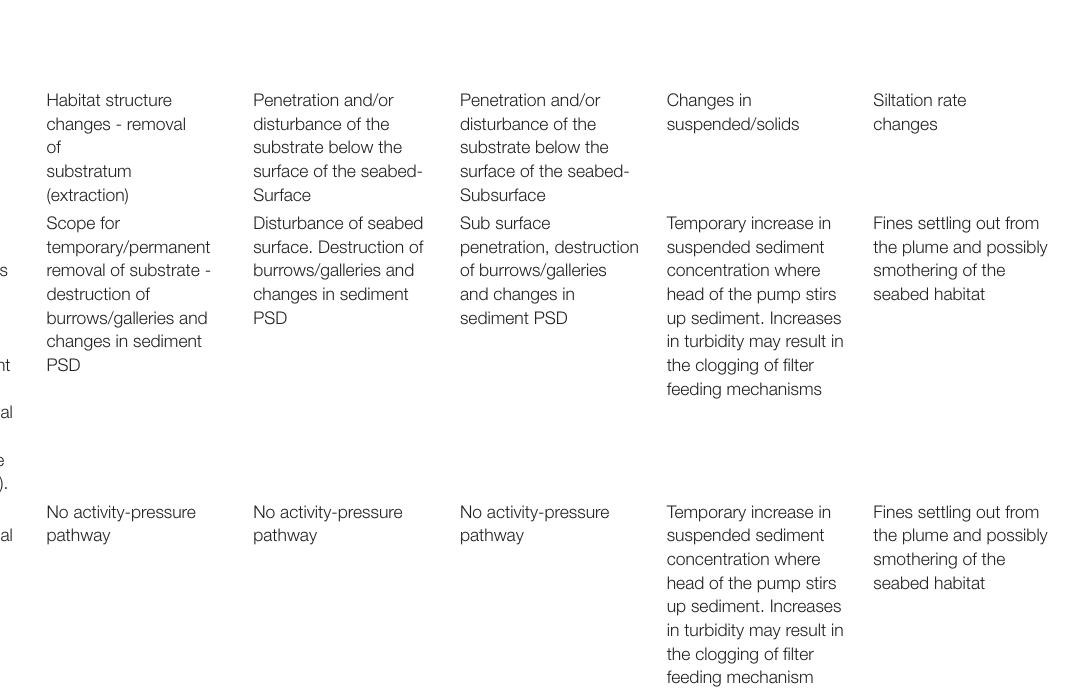
TABLE 2 | Exert of the benthic receptors pressure-activity matrix. Key: No activity-pressure pathway or pathway highly unlikely and therefore screened out. Key: Activity-pressure pathway likely/potential and therefore screened